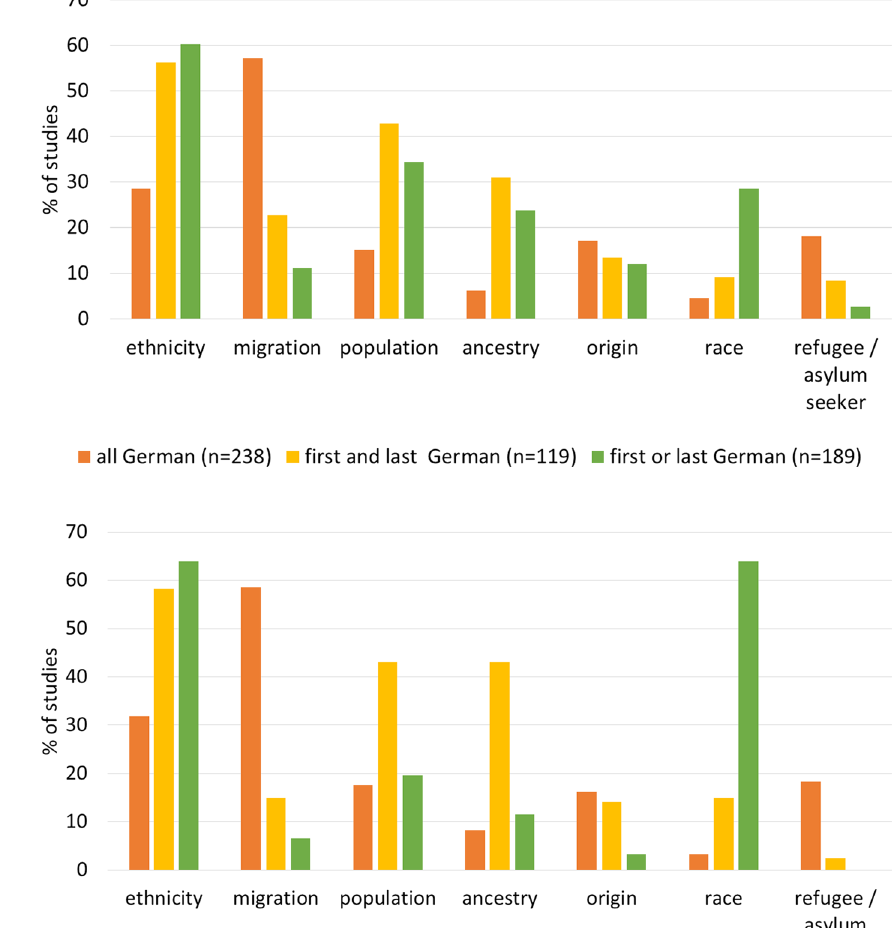
Fig. 2 Frequency of classifica- tion terms used in relation to